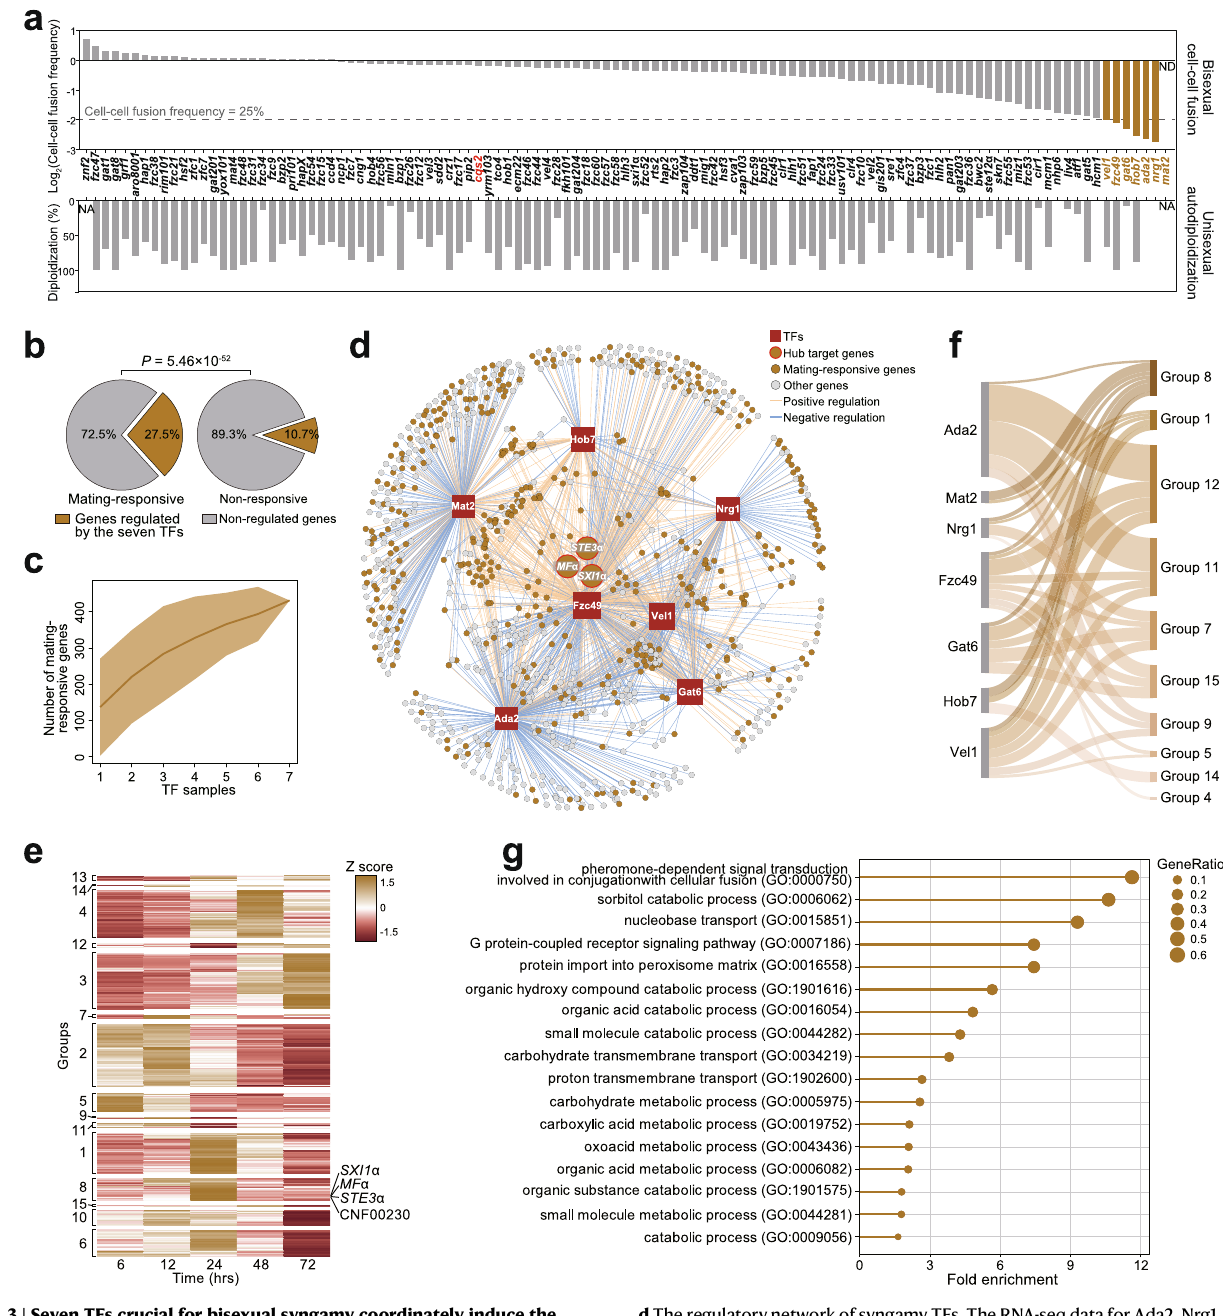
d TheregulatorynetworkofsyngamyTFs.TheRNA-seqdataforAda2,Nrg1,Fzc49, Gat6,Hob7,andVel1weregeneratedinthisstudy,whileRNA-seqdataforMat2was obtained from previous work 56 . The square and the circle indicate TFs and their targets,respectively.Yellowandgraycirclesrepresentmating-responsiveandnon- mating responsive genes, respectively. Positive and negative regulation are indi- cated by yellow and blue edges, respectively. e Transcriptional pro fi les of 15 gene groups identi fi ed based on publicly available time-series RNA-seq data targeting different developmental stages after mating induction 21 . Red indicates low expression; yellow indicates high expression. f Sankey diagram showing the reg- ulatory connections between the syngamy TFs and the gene groups. Regulatory connections shown were statistically signi fi cant (one-sided Fisher ’ s exact test, P <0.05).TheFisher ’ sexacttestresultisdescribedinmoredetailinSupplementary Fig.2d. g Geneontology(GO)analysisofgenesingroup8.Sourcedataareprovided as a Source Data fi